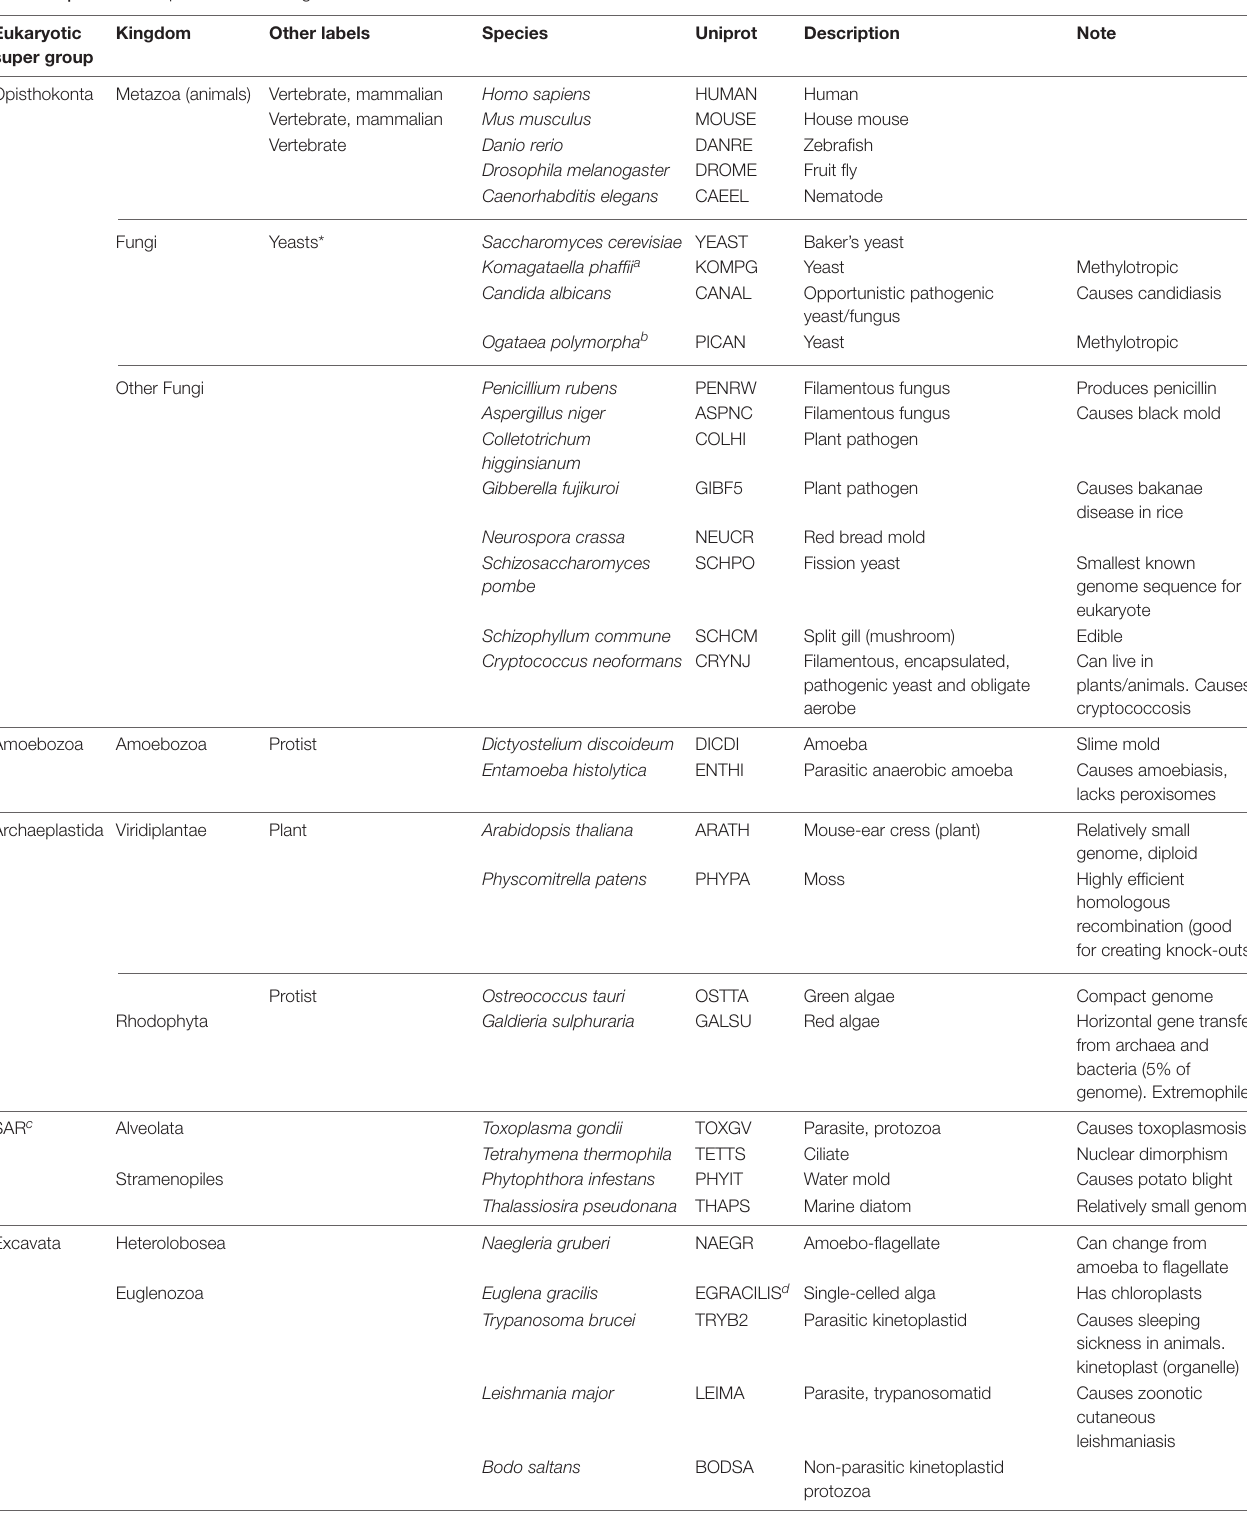
TABLE 1 | Overview of proteomes